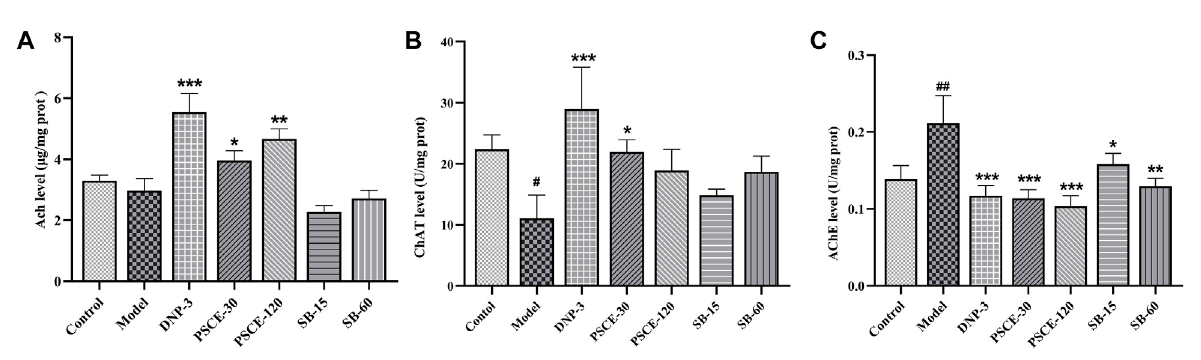
FIGURE 9 Effects of PSCE and SB on scopolamine-induced cholinergic index. (A) Ach activity in cerebral cortex. (B) ChAT activity in cerebral cortex. (C) AChEactivityincerebralcortex.TheexperimentaldatawereexpressedbyMeans±SEM(n=10pergroup).Comparedwith normalgroup, # p < 0.05,